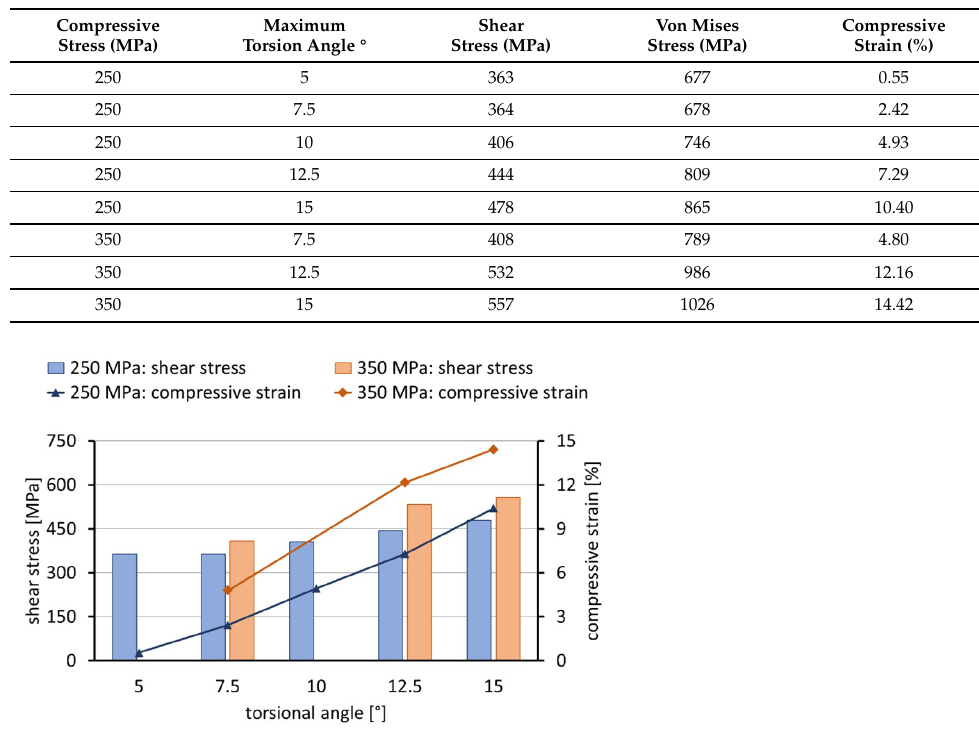
Figure 5. Graphical presentation of data in Table 3: max. shear stress at beginning of experiment, max. compressive strain at the end of each